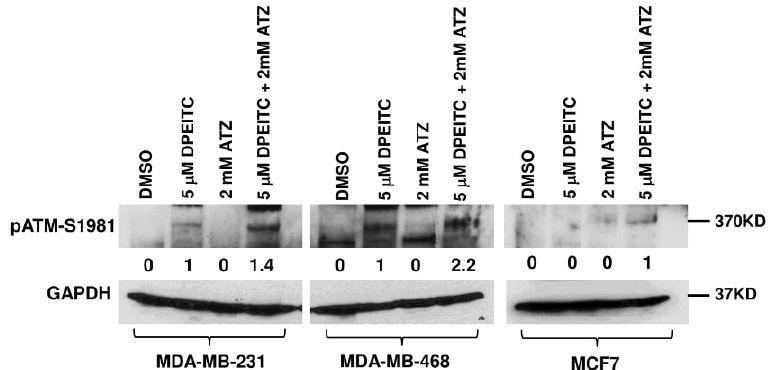
Figure 4. Effects of DPEITC and ATZ co-treatment on activation of ATM in mutant p53 TNBC cells. MDA-MB-231 (p53 R280K ), MDA-MB-468 (p53 R273H ), or MCF7 (WT p53) cells were treated with DMSO, 5 µ M DPEITC, 2 mM ATZ, or both for 24 h. Blots were probed using the anti-pATM S1981 antibody and re-probed with the GAPDH antibody. Experiments were performed in triplicate.